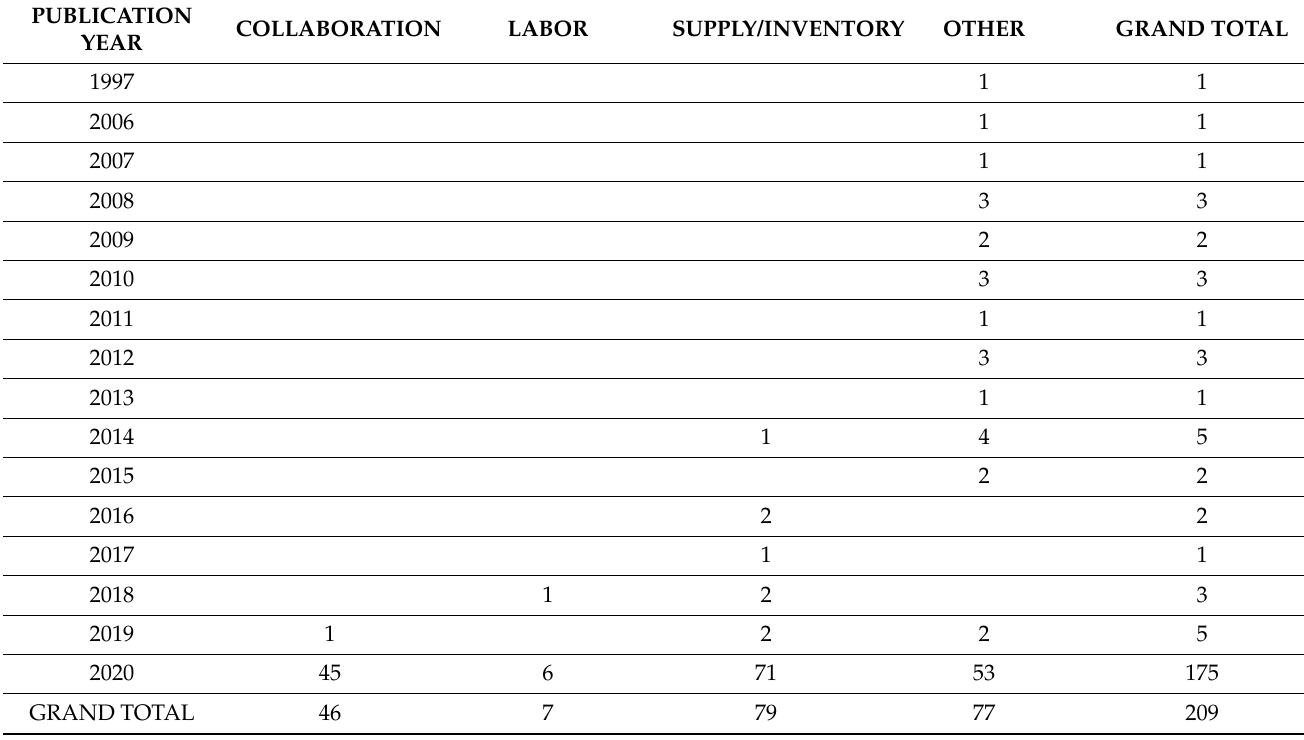
Table 8. Research Articles by Supply Chain